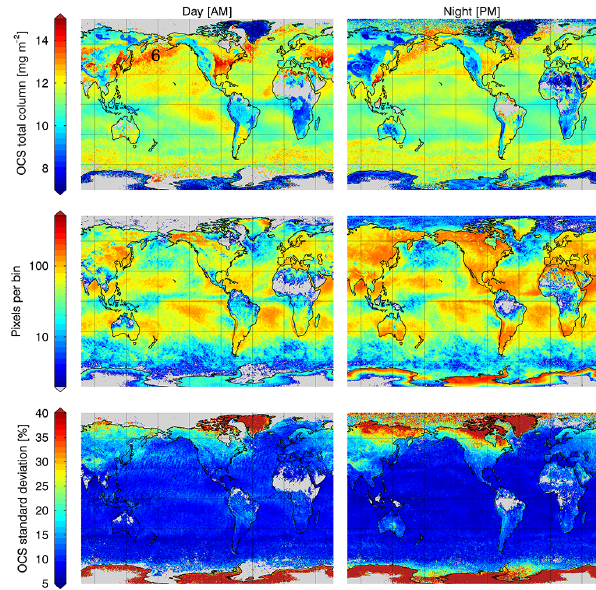
Figure 11. Same as in Fig. 10, but for March–April 2014.